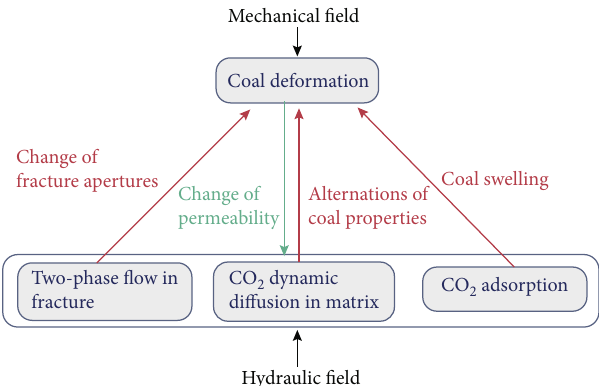
Figure 5: Cross-couplings between fl uid transfer and coal